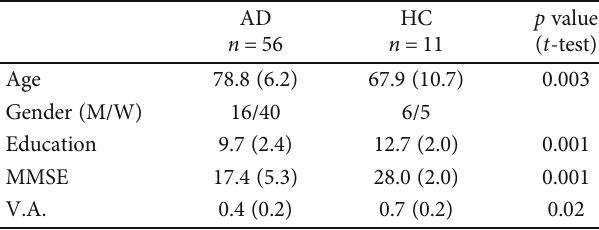
Table 1: Demographics for the two